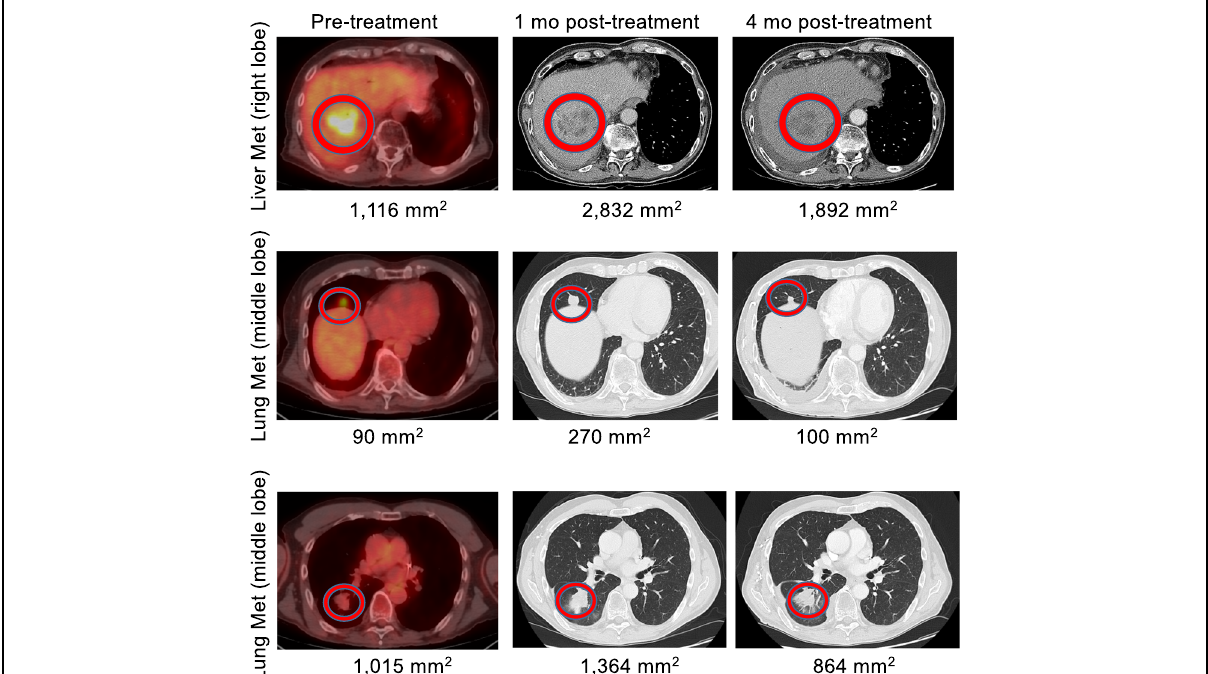
Fig. 6 Imaging results. Photographs show the PET (pre-treatment) and CAT (post-treatment) scans, capturing 3 different metastatic sites. The estimated lesions size is indicated underneath each